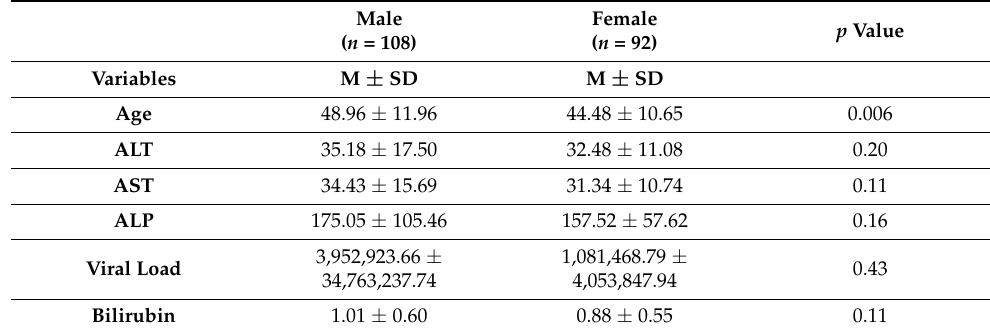
Table 3. Association of age and biochemical parameters based on gender.